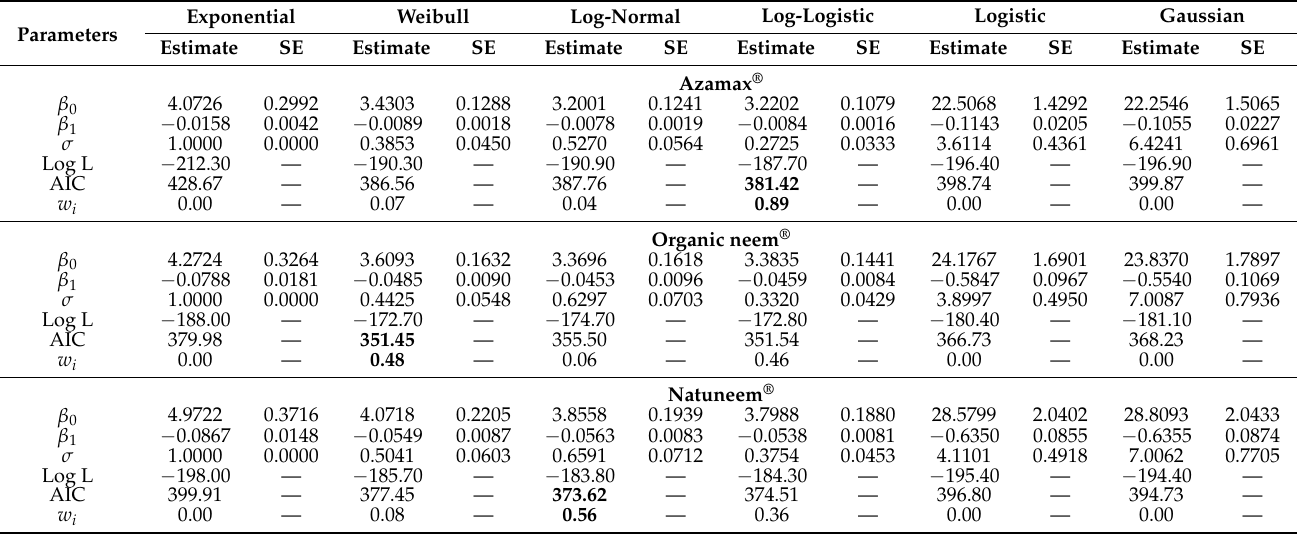
Table 2. Parameter estimates and standard errors (SE), Akaike information criterion (AIC), and Akaike weights (w i ) for the models used in the analysis of Chrysoperla externa exposed to neem-based